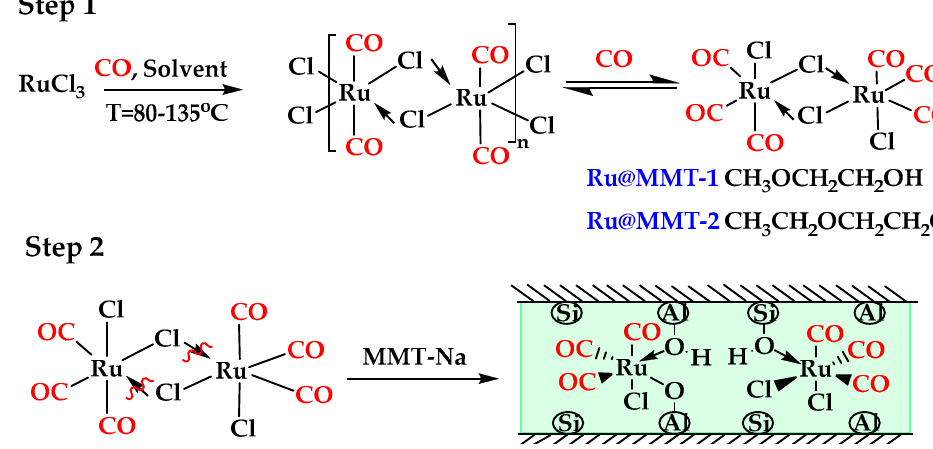
Figure 2. The development route for CORM’s precursor (Step 1); the CO administration strategy intercalates the CORM-2 inside the montmorillonite (MMT) layers (Step 2).